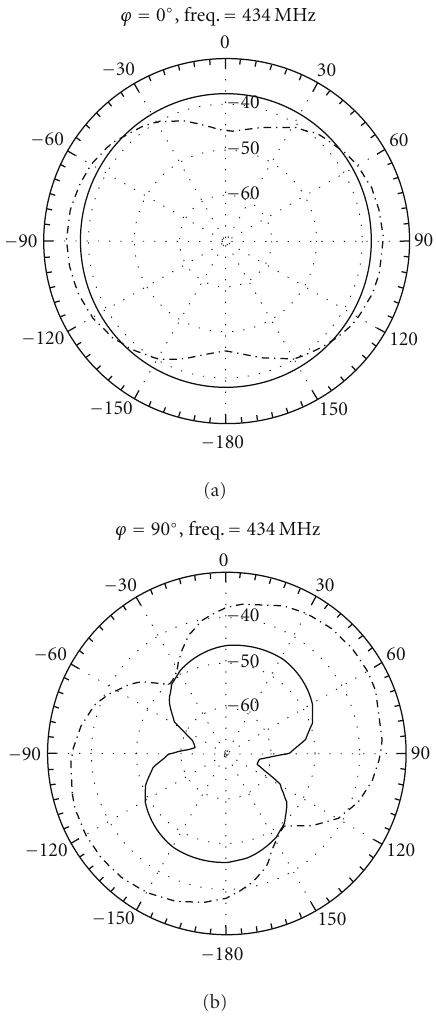
Figure 8: Radiation pattern G ϕ (dot dash) and G θ (solid) at 434MHz and 25 Ω access as